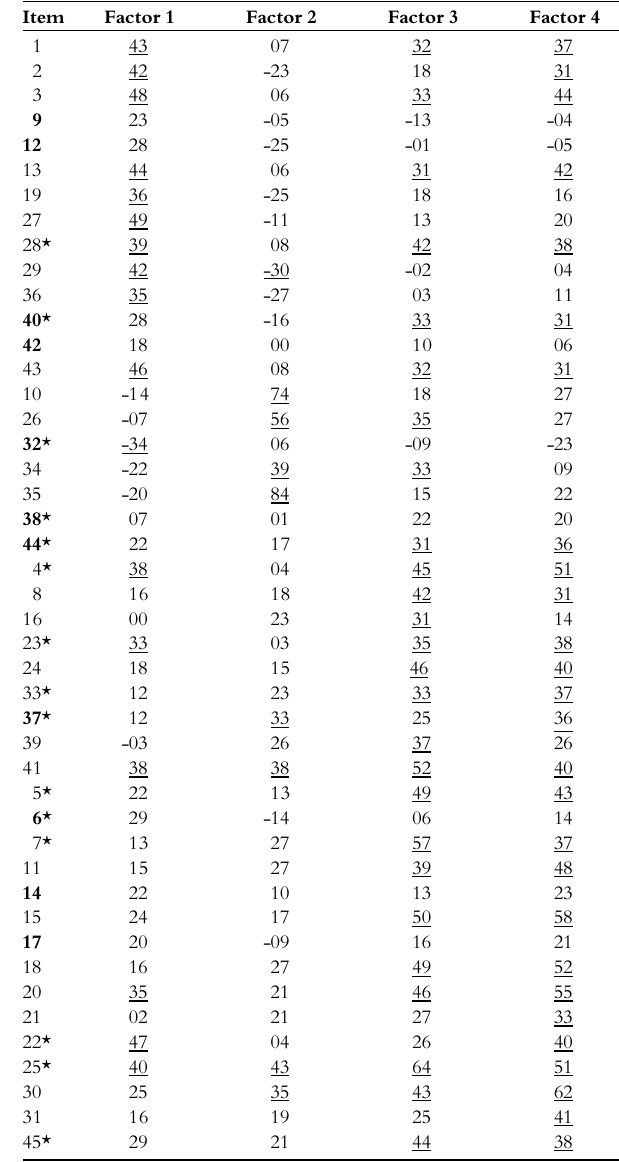
0.30 on their postulated factors are printed in